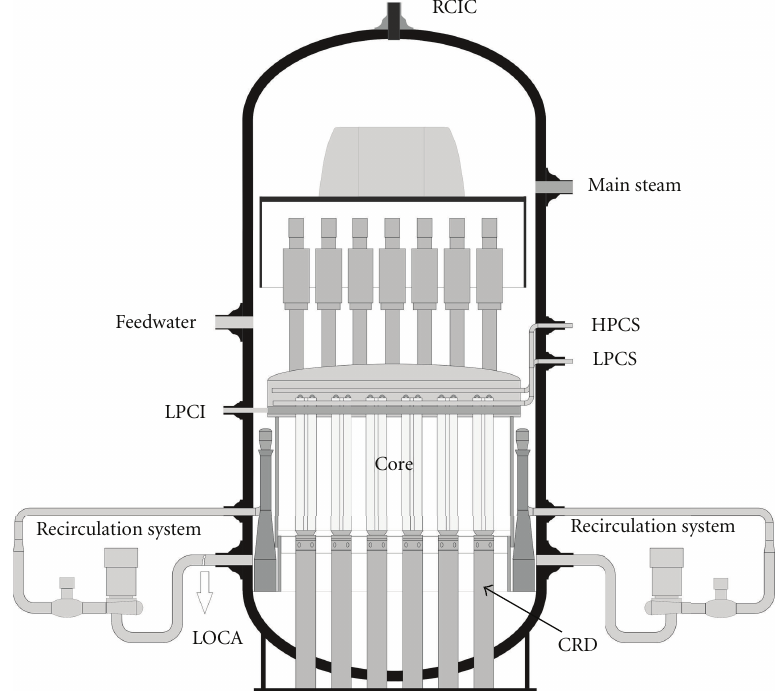
Figure 1: Schematic diagram of the boiling water reactor (BWR) [9].